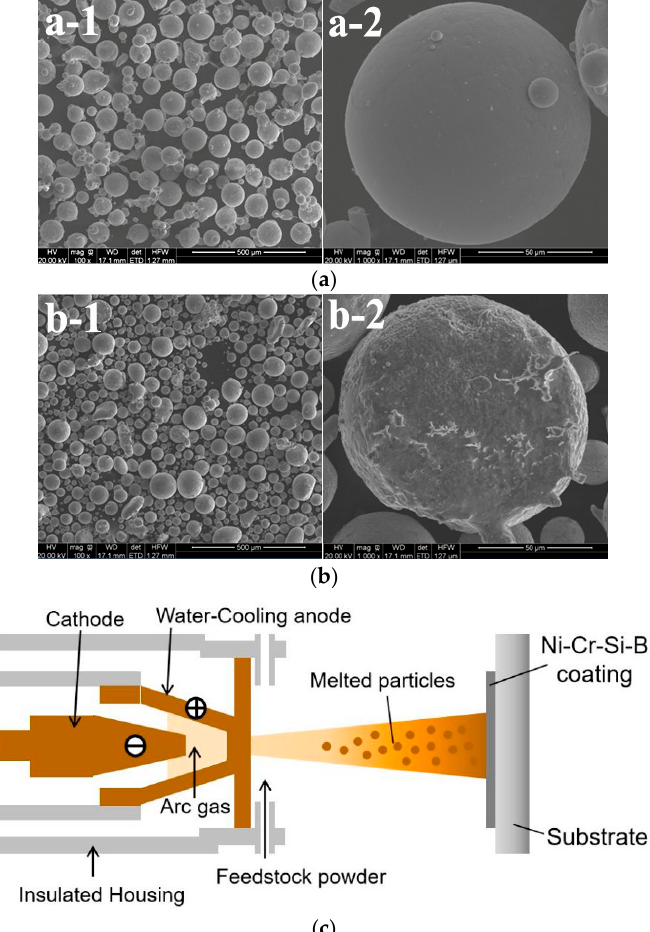
Figure 1. SEM images of ( a ) raw NiCrBSi powder and ( b ) plasma sprayed NiCrBSi powder. ( a-1 , b-1 ): low magnification, ( a-2 , b-2 ): high magnification. ( c ) Diagram of the APS (atmospheric plasma spray) system.